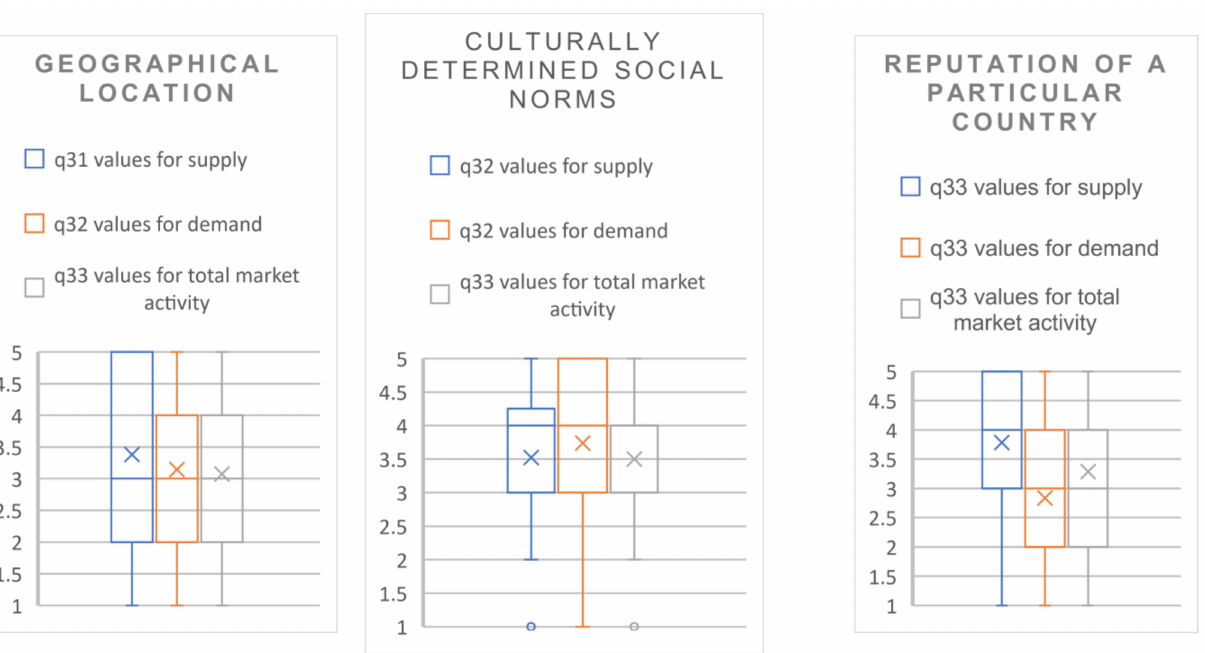
Figure 5. Values of the factors belonging to the metacategory “embedded